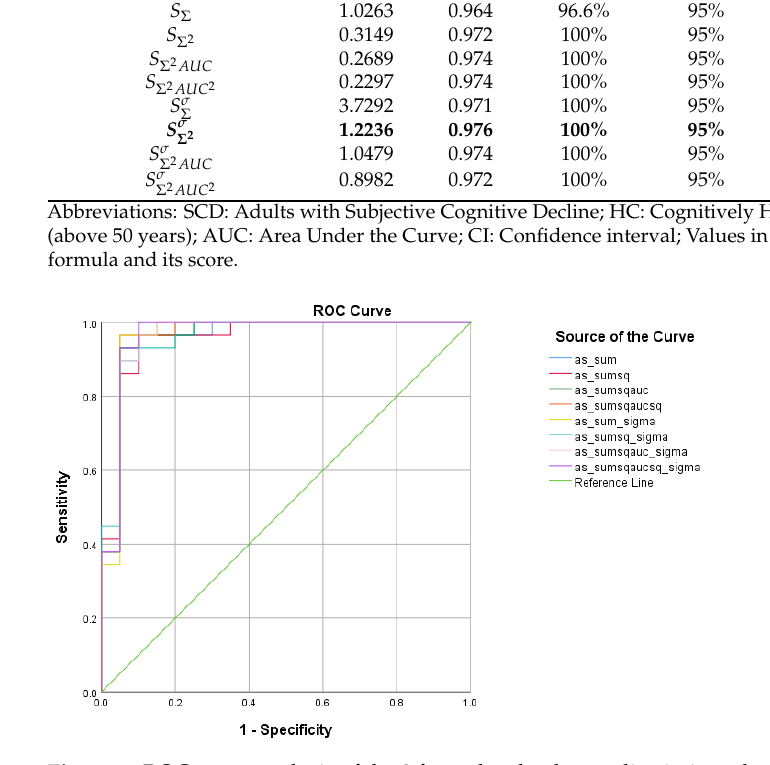
Figure 4. ROC curve analysis of the 8 formulae that better discriminate between Subjective Cognitive Decline (SCD) and Cognitively Healthy Advanced-age Adults (HC).